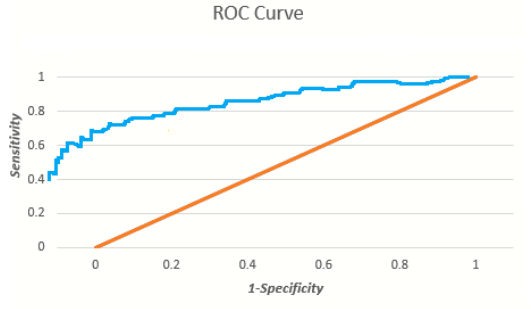
Figure 15. ROC Curve